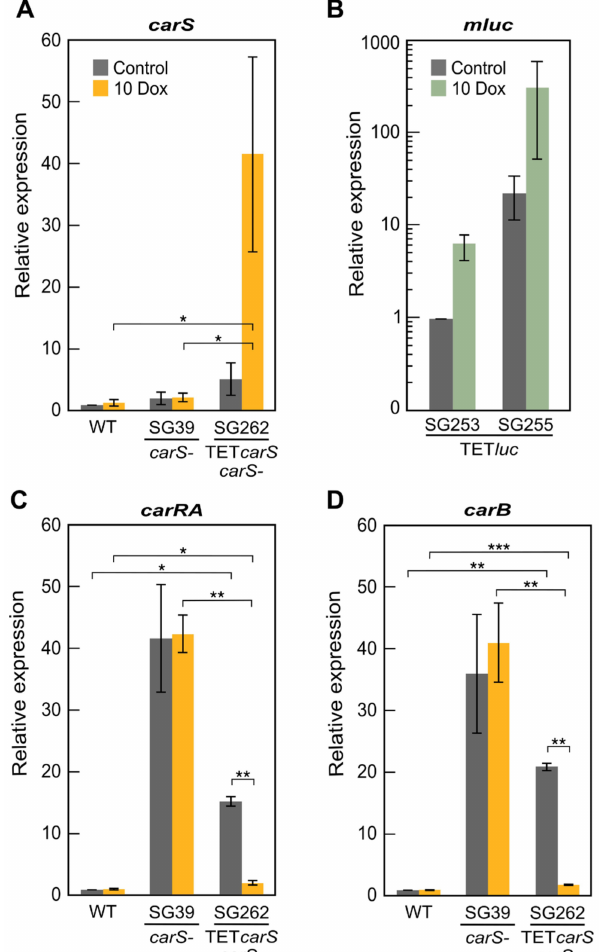
Figure 6. Effect of optimized Dox concentration on gene expression: ( A ) Transcripts levels for the carS gene in the wild strain (WT), carS mutant (SG39), and TET carS transformant (SG262). ( B ) Transcript levels for the mluc gene in TET luc transformants SG253 and SG255. Values were normalized to those of SG253 in the absence of Dox. ( C ) Transcript levels for the carRA gene in WT, SG39, and SG262. ( D ) Transcript levels for the carB gene in WT, SG39 and SG262. The strains were grown for two days in DG medium in darkness, then induced with 10 µ g/mL Dox (10 Dox) for 24 h; noninduced cultures (control) were incubated for the same time. Data of qRT-PCR are the average and standard deviation of three independent experiments. Values were normalized to those of the noninduced wild strain, except for the mlu c gene. * p < 0.05; ** p < 0.01; *** p <